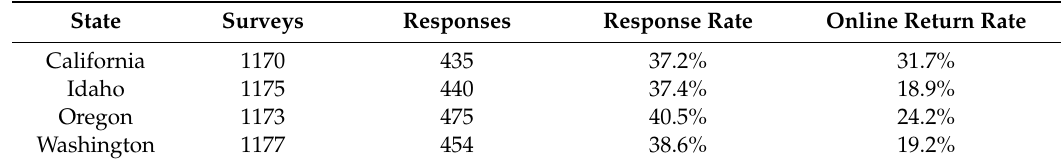
Table 1. Survey response